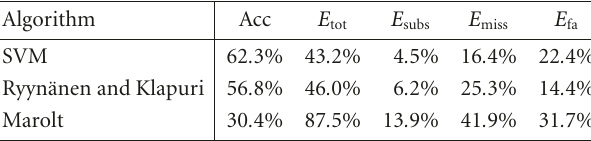
Table 4: Note onset transcription results.